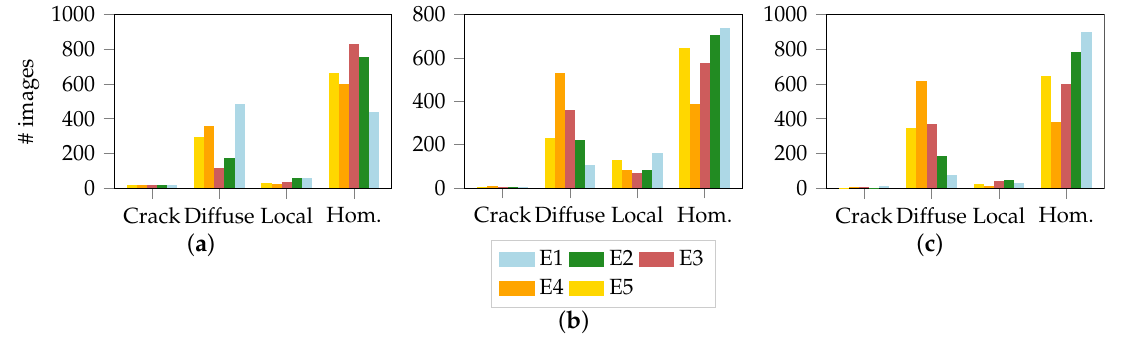
Figure 10. Marginal expert distributions per geometry of DP800: ( a ) S050-uniaxial strain. ( b ) S110-near plane strain. ( c ) S245-equibiaxial strain.